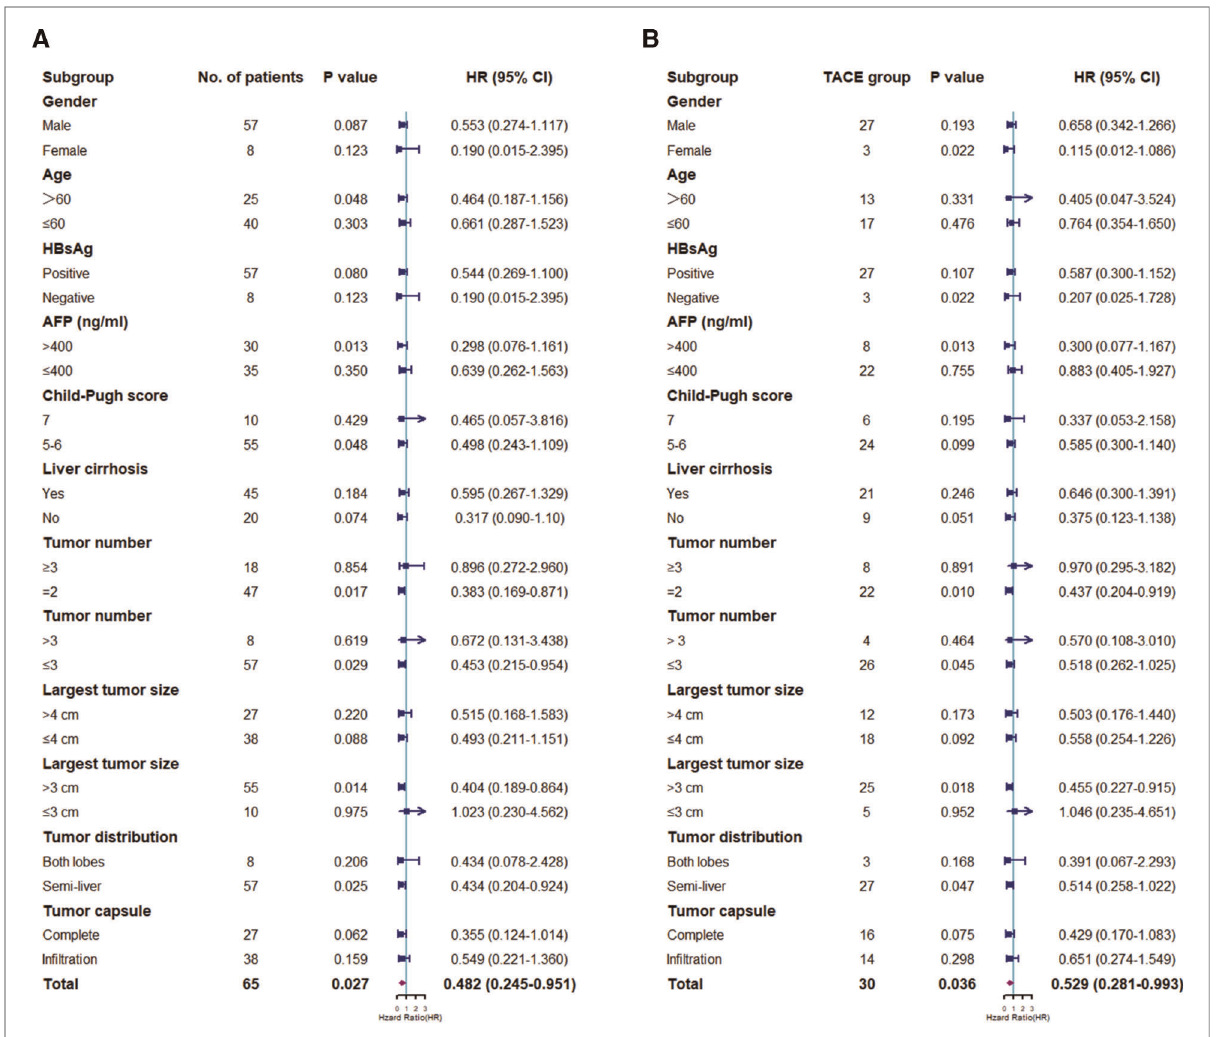
FIGURE 3 Subgroup analyses of overall survival ( A ) and progression-free survival ( B ) for prognostic factors. HR, hazard ratio; CI, con fi dence interval; HBsAg, hepatitis B surface antigen; AFP, α -fetoprotein; LR, liver resection; TACE, transarterial